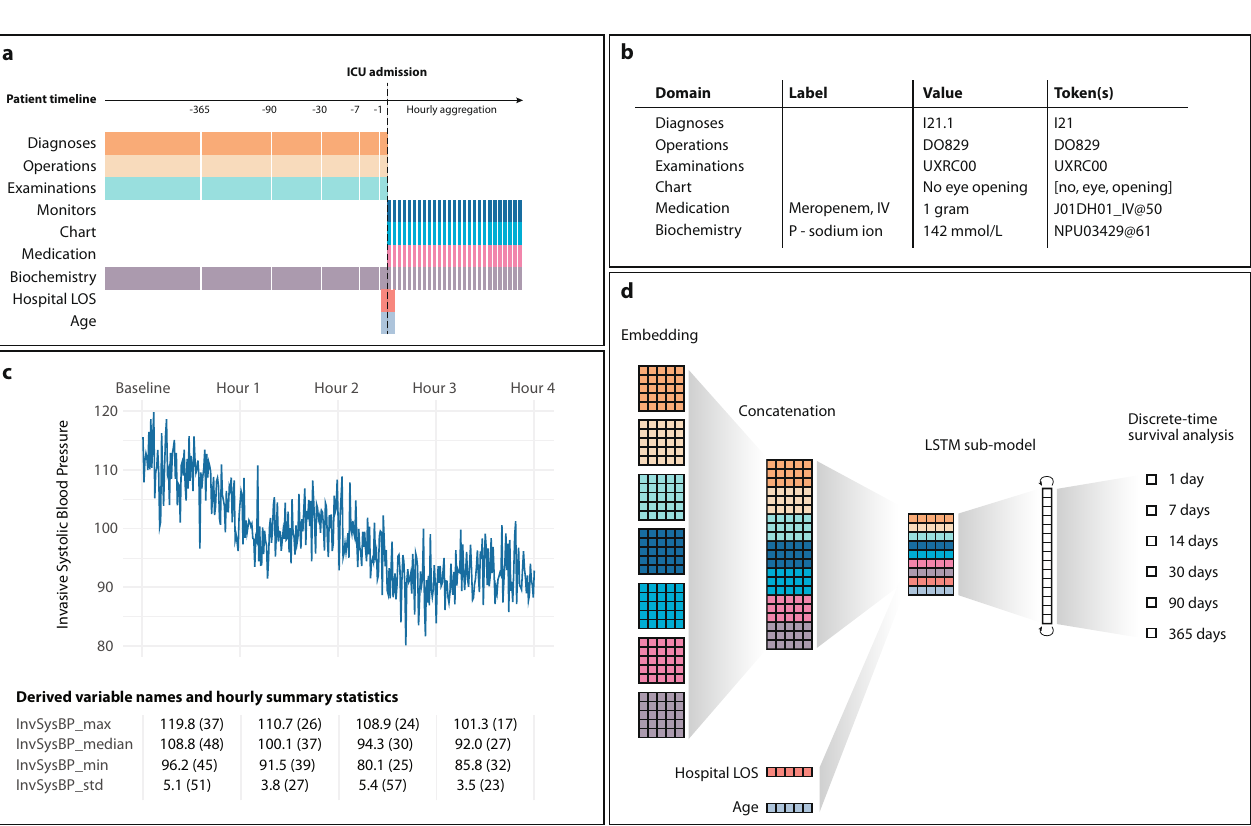
Fig. 5 A schematic illustration of data processing and model architecture, inspired by natural language processing with input data cast into tokens. a The nine input data domains and the discretisation of time into windows (represented by rectangles) with greater granularity after ICU admission than before. b Tokenisation of six domains; for example, a three-word note in the chart yields three distinct tokens and 1 gram Meropenem (with ATC code J01DH01) administered intravenously is the 50-percentile in our data and so yields the J01DH01_IV@50 token. c This panel uses fi ctive recordings to exemplify the aggregation of high-sample-rate and high-frequency data to hourly summary statistics (maxima, minima, medians, and standard deviations) with their corresponding percentiles in parentheses; as such, one resultant token would be InvSysBP_max@37. d To make the model handle this data representation, the fi rst layer consists of a separate embedding space for each input domain, which is updated during training of the model. age and length of hospital stays before ICU admission (Hospital LOS) are added deeper in the model as numerical values. The output nodes constitute a dense (linear) layer, in which each node yields the predicted probability of surviving the corresponding window (e.g., output node 1 ~ probability of surviving the fi rst day and output node 2 ~ probability of surviving from days 2 through